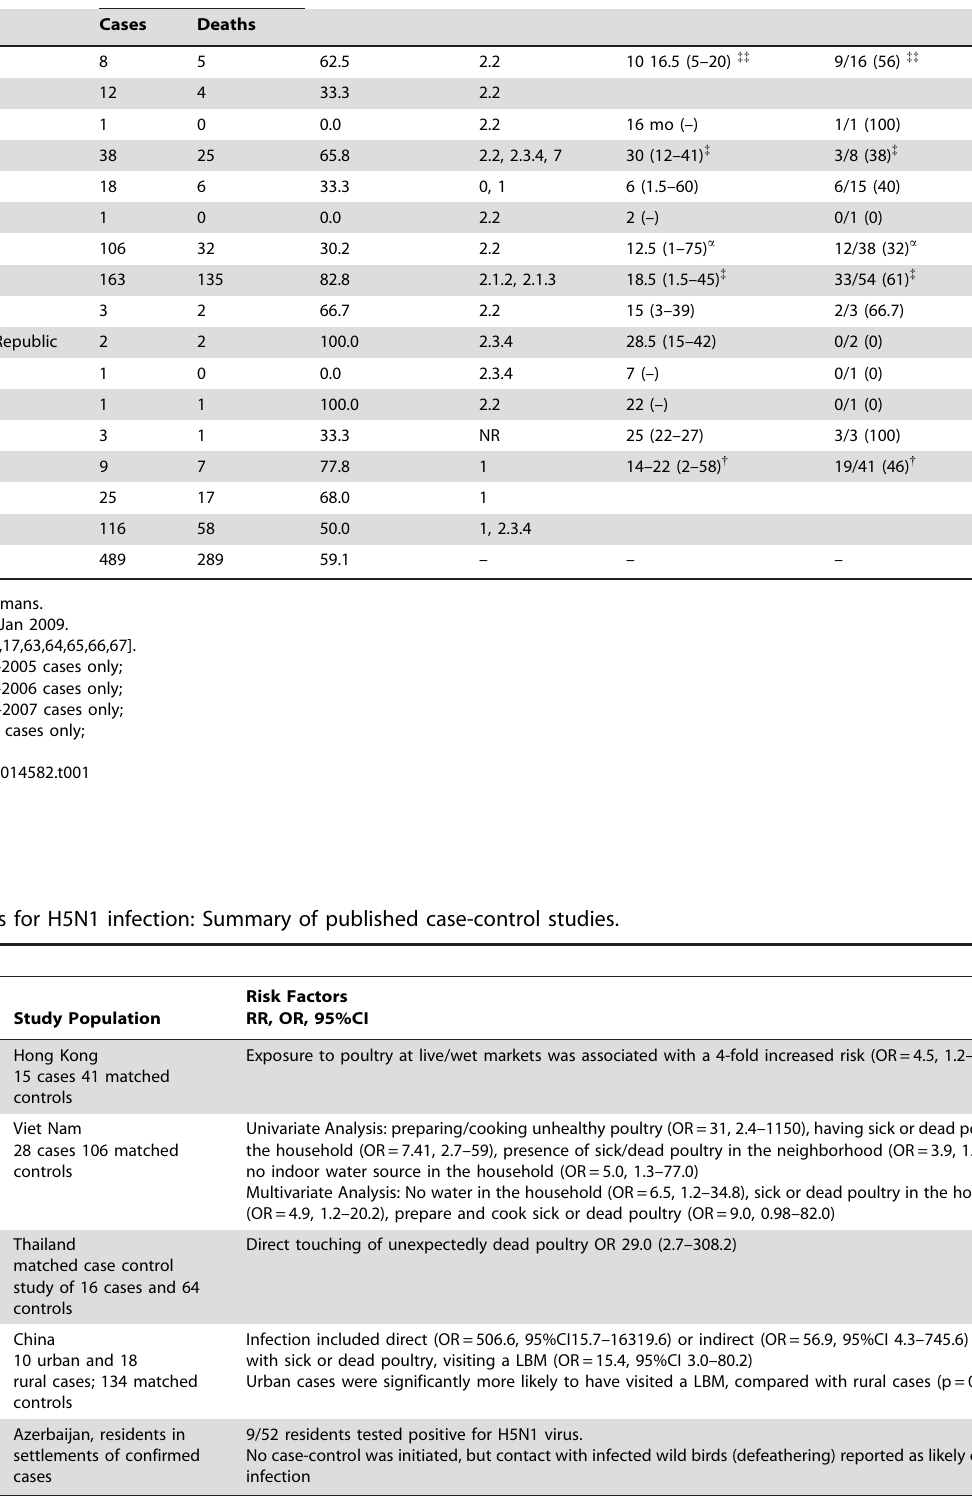
Table 1. Characteristics of human cases of highly pathogenic avian influenza H5N1 virus infection reported to WHO from 1997 to 16 March 2010 by country.